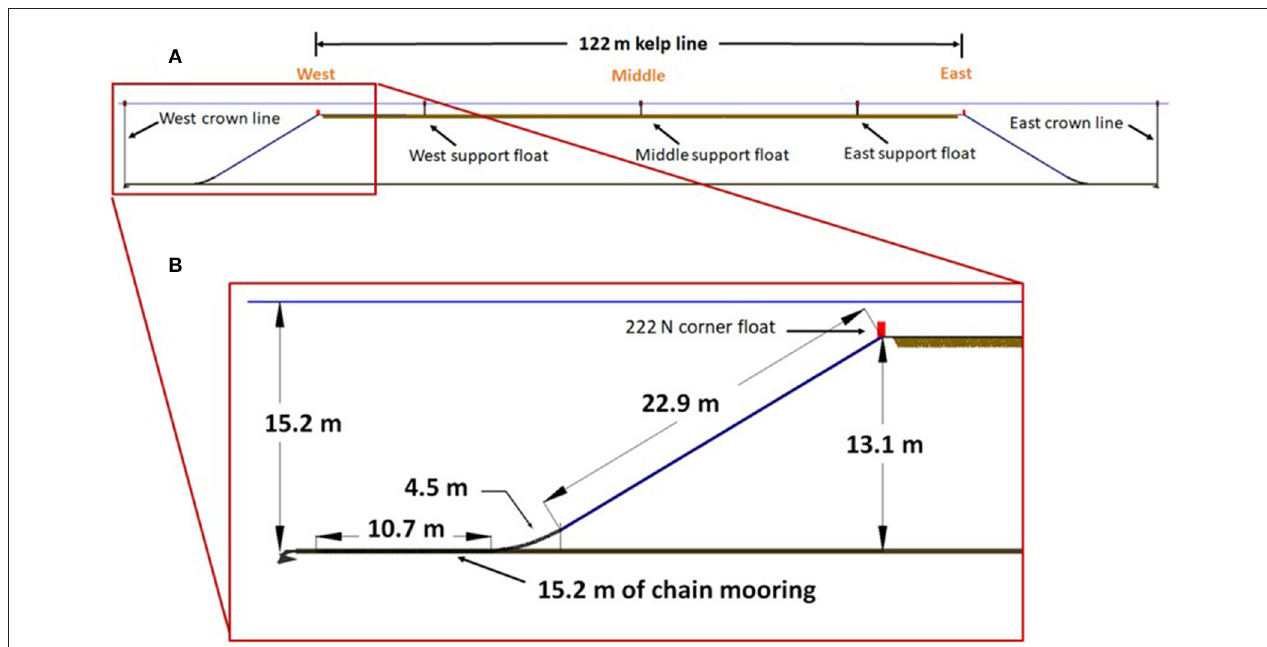
FIGURE 2 | (A) The dimensions of the kelp aquaculture system deployed at the exposed site. (B) Mooring line detail only depicted for the western leg as the eastern mooring is identical.